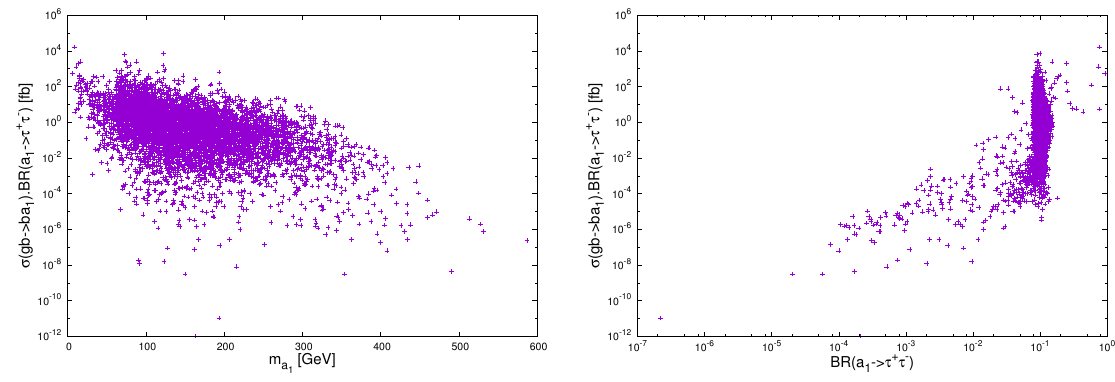
Figure 4. The production rates σ ( gg → a 1 ) BR ( a 1 → τ + τ − ) as functions of both m a ( left ) and BR ( a 1 → τ + τ − ) ( right ) [56]. 1 A partonic signal-to-background (S/B) analysis for the process pp → a 1 b → b τ + τ − was done in Ref. [56] where extraction of the a 1 signature was proven for several benchmark √ B (where S and B are points given in Table 1. Figure 5 shows the signal significance S / the signal and background rates, respectively), left plot, and the corresponding signal event rate S , right plot, as functions of the integrated luminosity. One can see that the discovery of the light a 1 at the LHC may occur for a 1 masses between ≈ 90 and ≈ 150 GeV √ B , are good at a luminosity of O (300 f b − 1 ) or more where the signal significances, S / enough to discover the a 1 in this mass region. Table 1. Four benchmark points used in the signal-to-background (S/B) analysis [56].